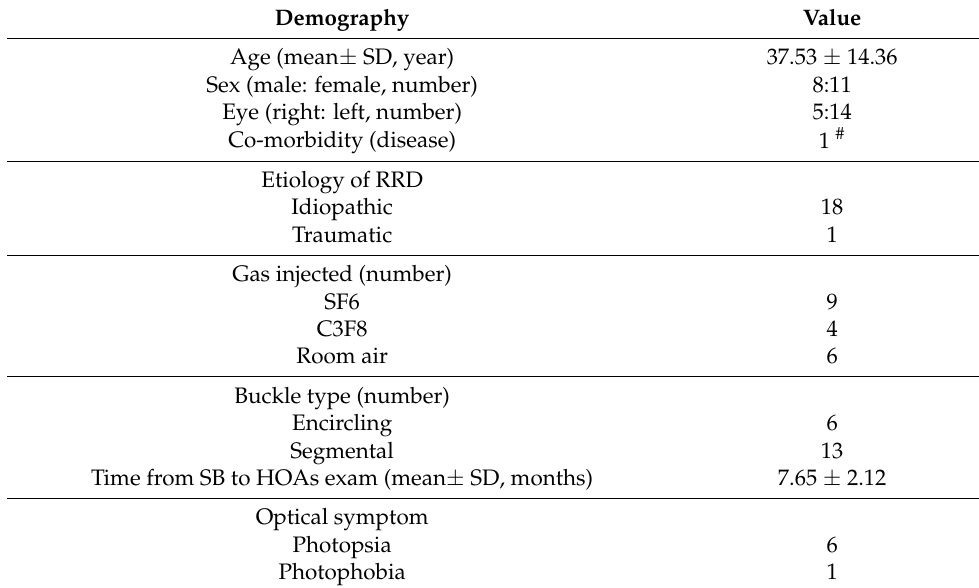
Table 1. Basic demography of the whole population.